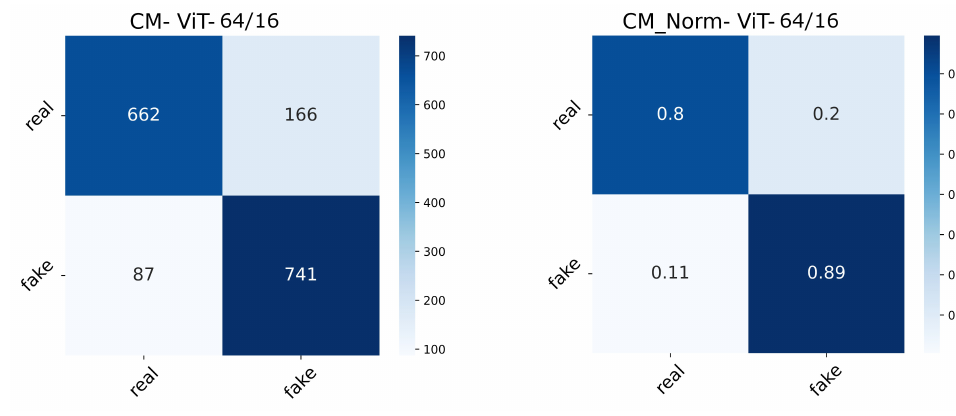
Figure 16. Confusion matrix (normal and normalized) of the ViT64/16 setting.